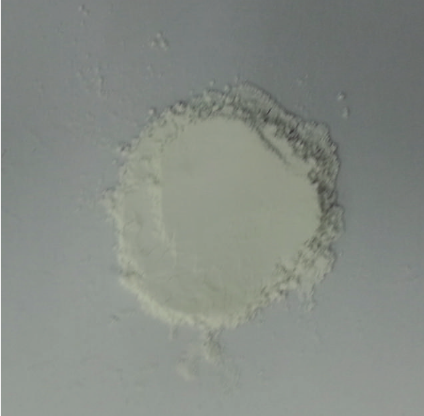
Figure 1: Photograph of as-prepared N-TiO 2